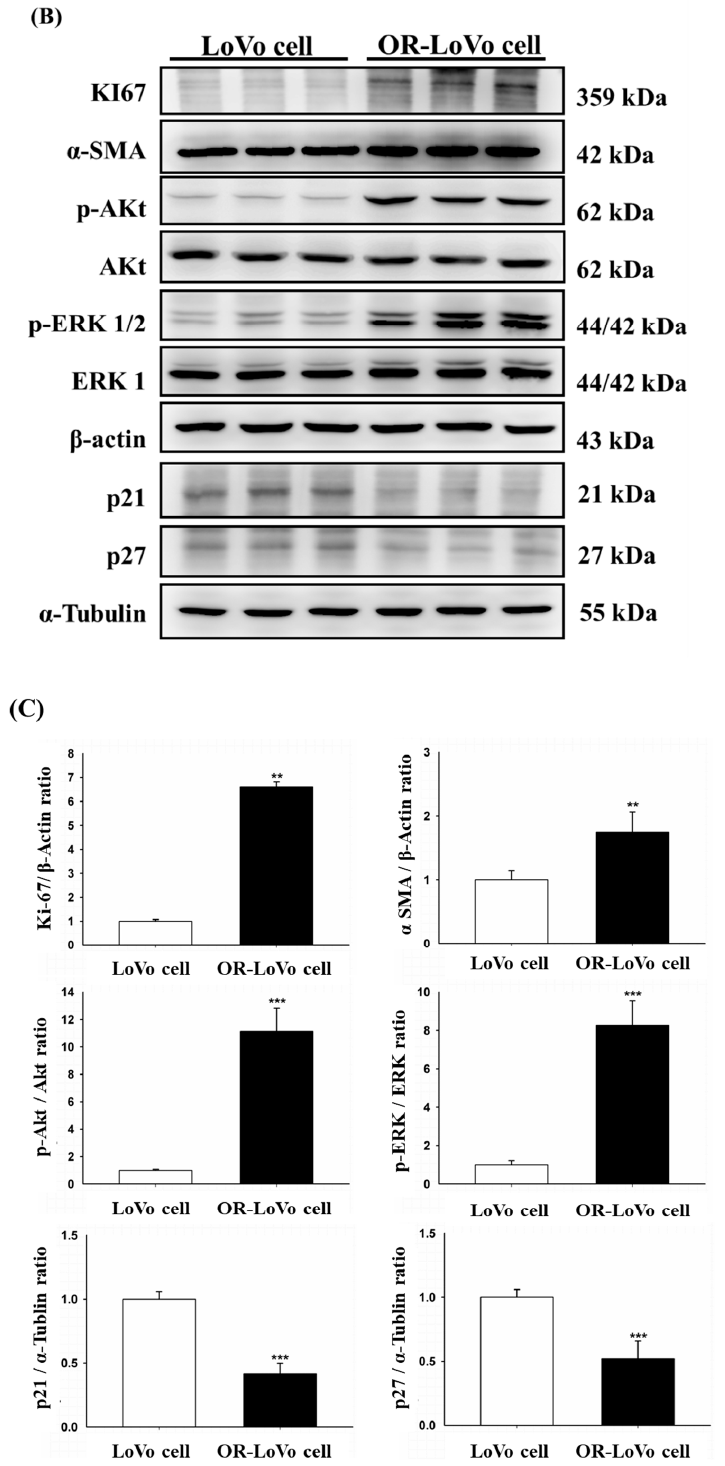
Figure 1. Cell properties differ between LoVo cells and oxaliplatin resistance (OR)-LoVo cells. ( A ) The MTT assay result indicates the survival rate of OR-LoVo cells after treatment with or without oxaliplatin (OXA) (45 µ M at 24 h) compared with the LoVo cell control group. ** p < 0.01 vs. the LoVo cell control group; *** p < 0.001 vs. the LoVo cell control group. ( B ) Expression of cell proliferation- and cell cycle checkpoint proteins in LoVo cells and OR-LoVo cells by Western blotting. ( C ) Quantification of the protein expression of Ki-67, α -SMA, p-Akt, p-ERK, p21, and p27 ( n = 3). ** p < 0.01 vs. LoVo cells; *** p < 0.001 vs. LoVo